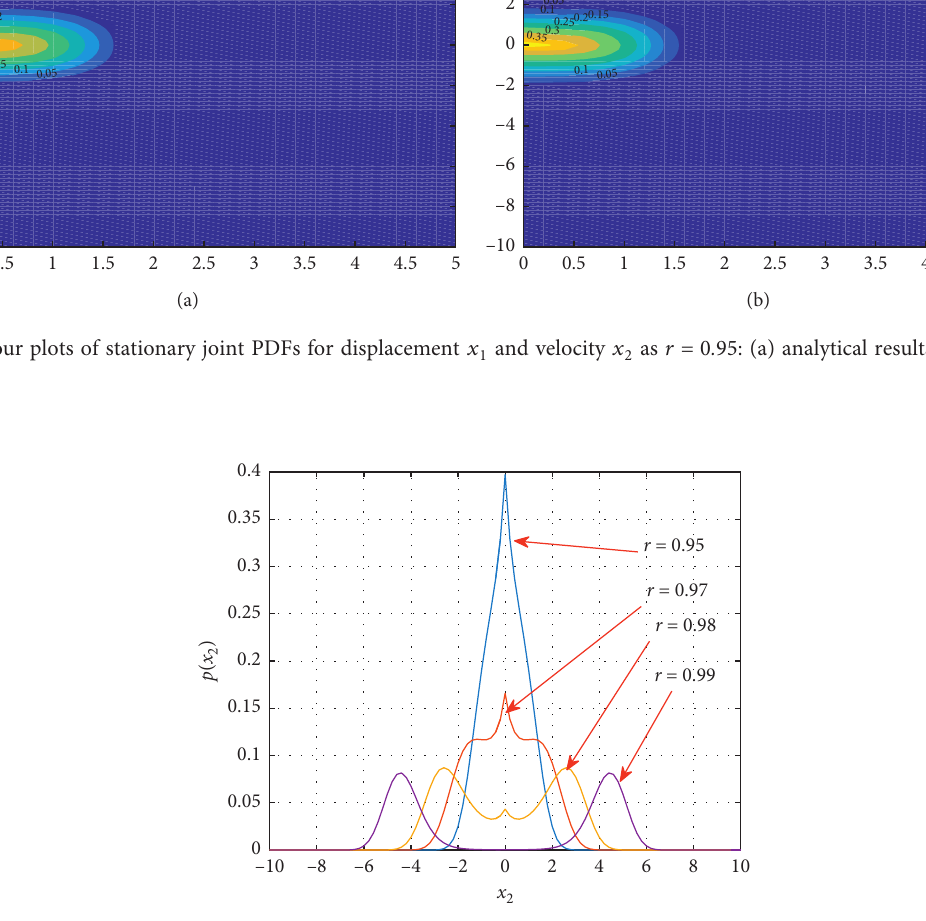
� 0 for different restitution coefficients r 1